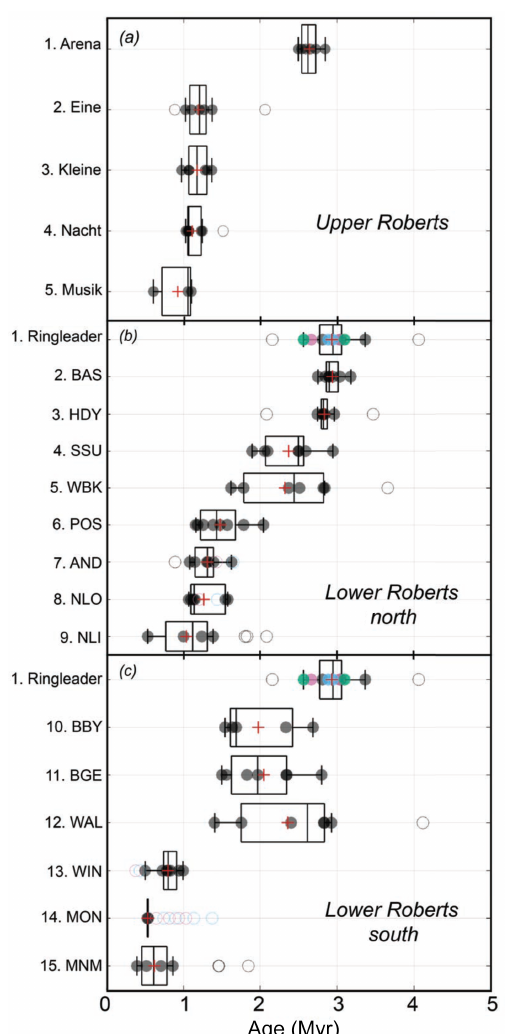
Figure 12. Boxplots showing moraine ages for the Plio-Pleistocene part of the Roberts Massif record. Moraines for each site (Upper Roberts and Lower Roberts northern and southern transects) are listed in stratigraphic order, with the outermost moraine at the top of each panel. Moraine numbers in (a) correspond to those in Fig. 7, while moraine numbers in (b) and (c) correspond to those in Fig. 4. The Ringleader moraine is shown in both panels (b) and (c) , as it is the uppermost moraine in both Lower Roberts transects. 3 He ages are black; 21 Ne ages are blue; 10 Be ages are pink; and 26 Al ages are green. Outliers are shown as open circles. The average moraine age is denoted by a red plus symbol.